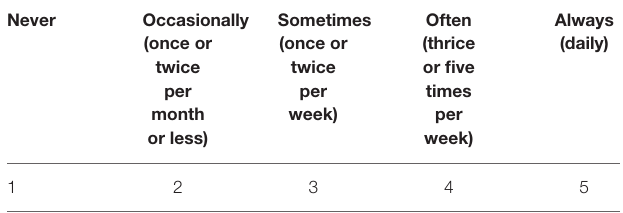
TABLE 1 | Five-point likert scale results for the sleep disturbance scale for children. Never Occasionally